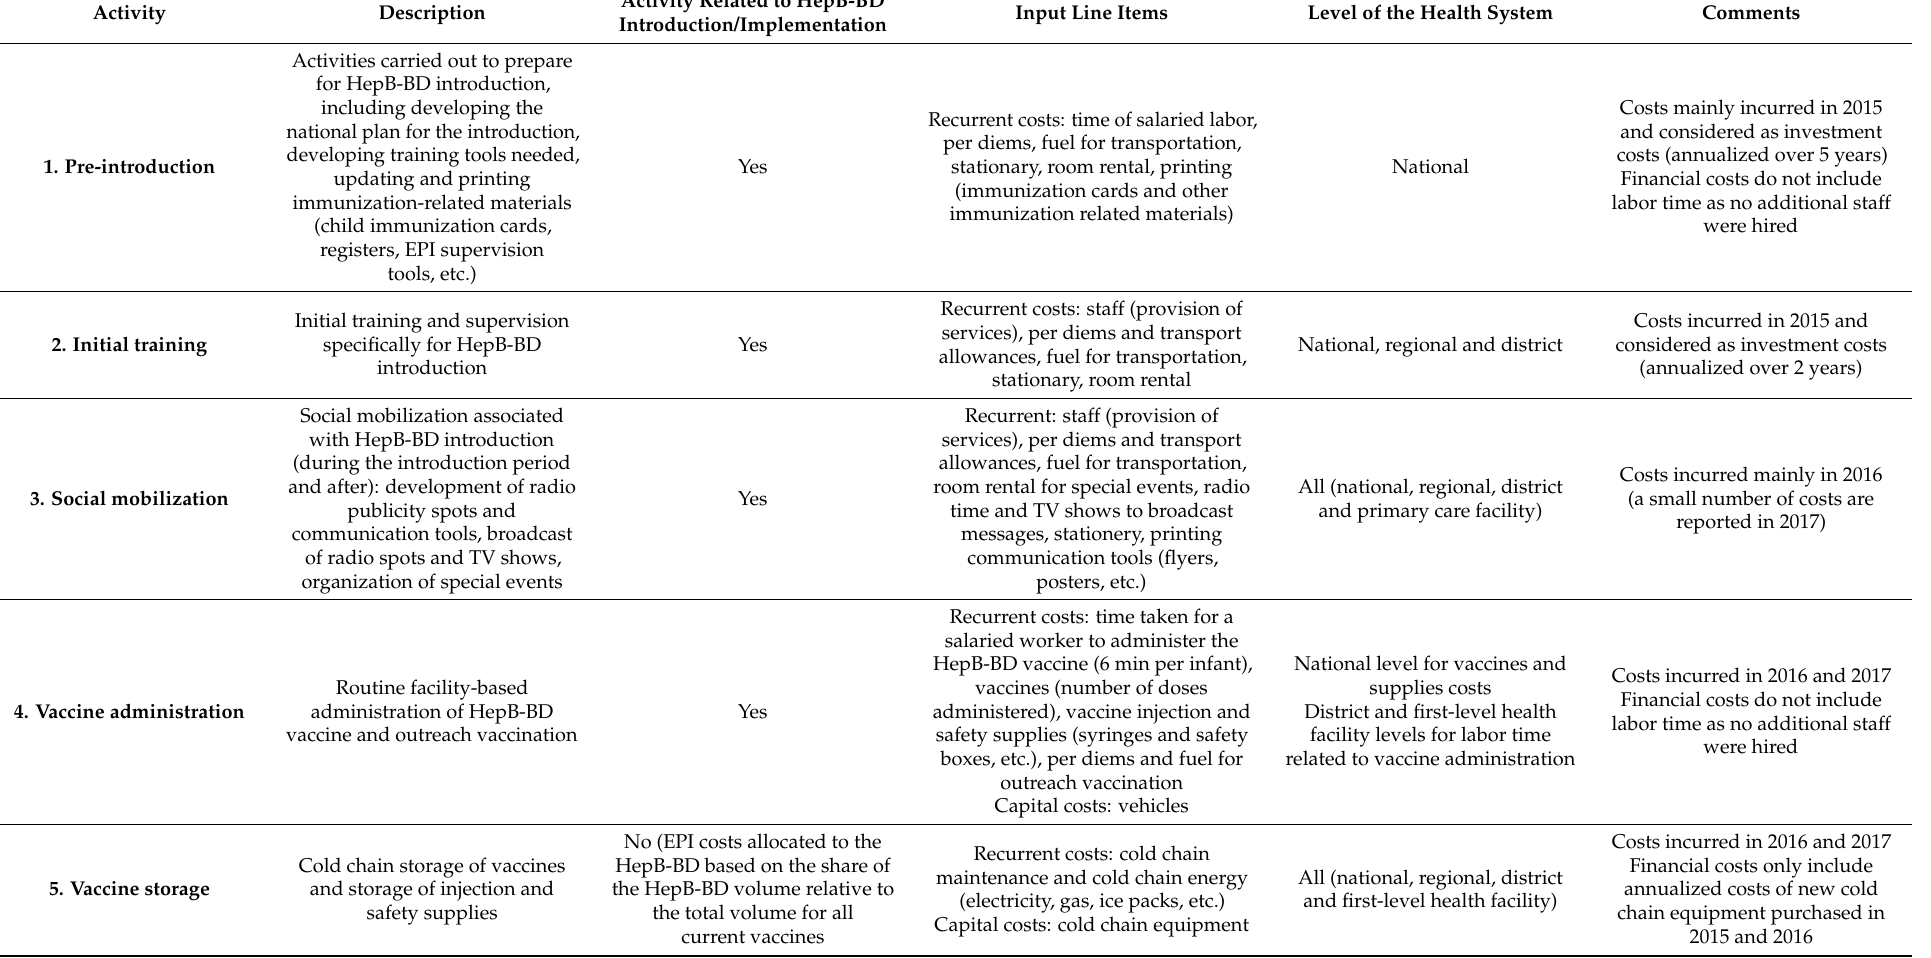
Table 1. Summary of the activities and input line items considered in the costing analysis covering the 2015–2017 period in